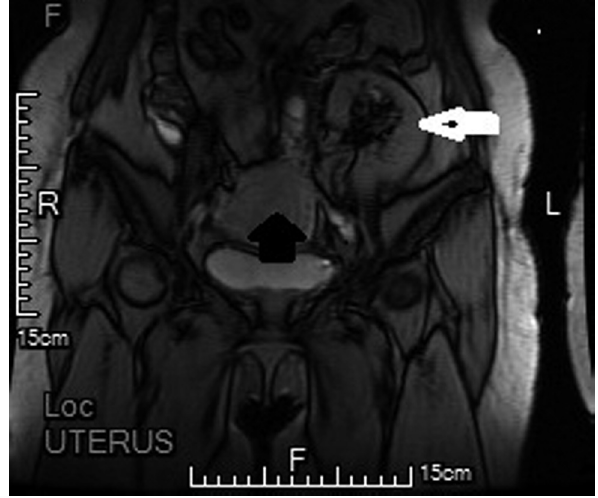
Figure 1: Preoperative MRI image. The white arrow indicates the transplanted kidney. The black arrow indicates the FIGO - stage IA endometrial carcinoma.